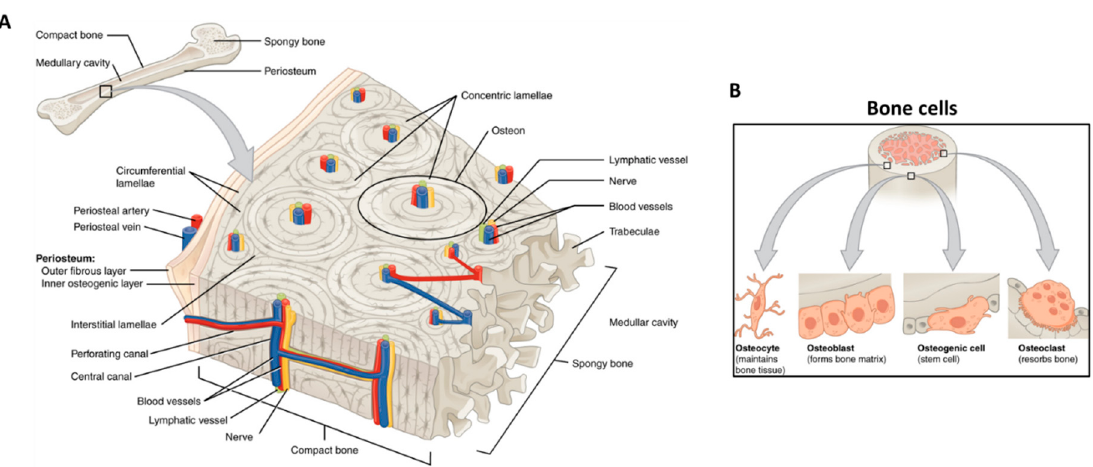
Figure 3. Bone tissue schematic showing: ( A ) bone structures (e.g., osteon, blood vessels, lamellae, periosteum, and trabeculae); and ( B ) the main bone cells (i.e., osteocyte, osteoblast, osteogenic cell, osteoclast) and their location. Adapted from OpenStax.